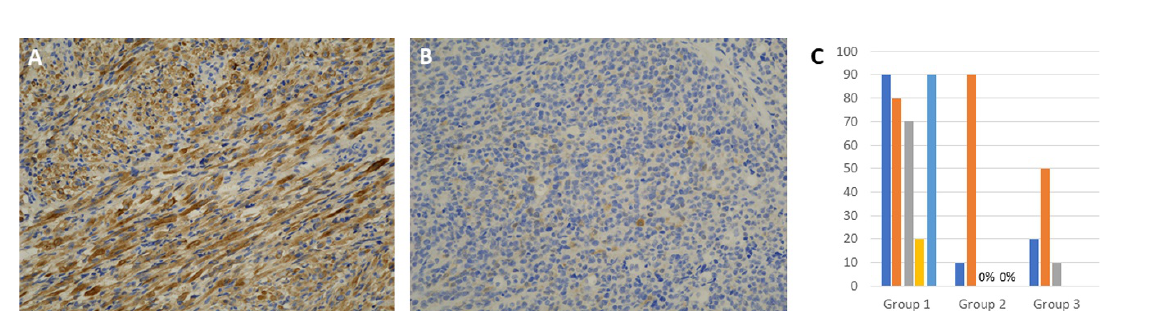
Figure 2. Immunohistochemistry for INPP4B: ( A ) Representative image of an SRMS from Group 1 showing strong, diffuse cytoplasmic immunoreactivity (×200). ( B ) Representative image from a Group 3 ERMS where tumor cells were mostly negative, except for a few scattered positive cells (×200). ( C ) A chart showing percentage immunoreactivity of INPP4B in individual samples.